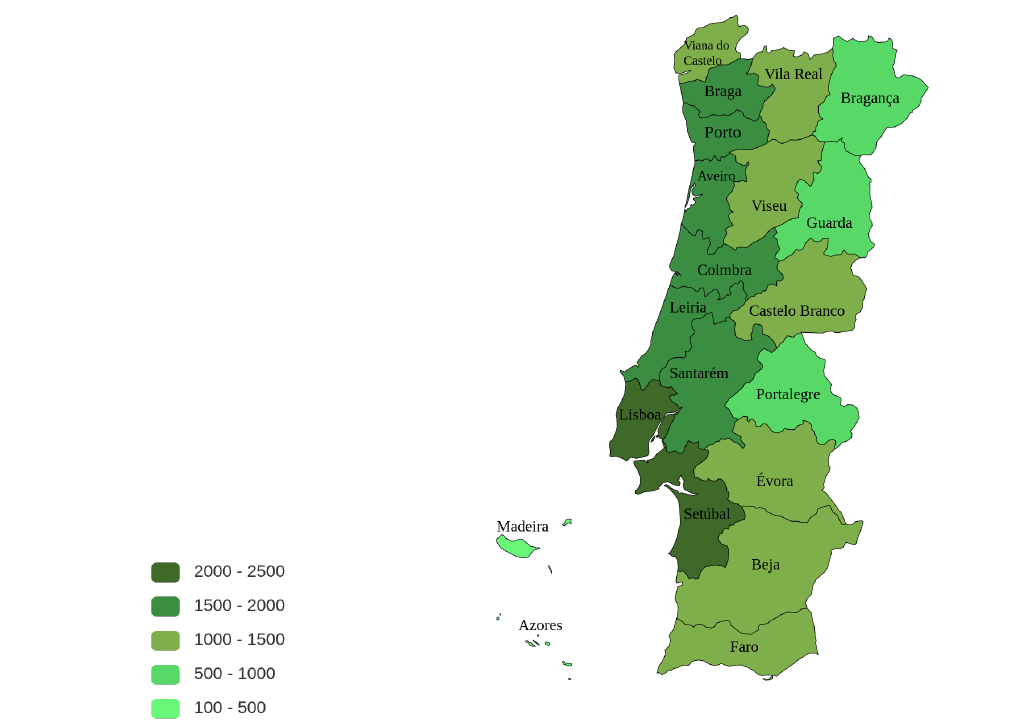
Figure 1. Total number of calls per district per 100,000 inhabitants (image generated using https: //paintmaps.com/, accessed on 9 November